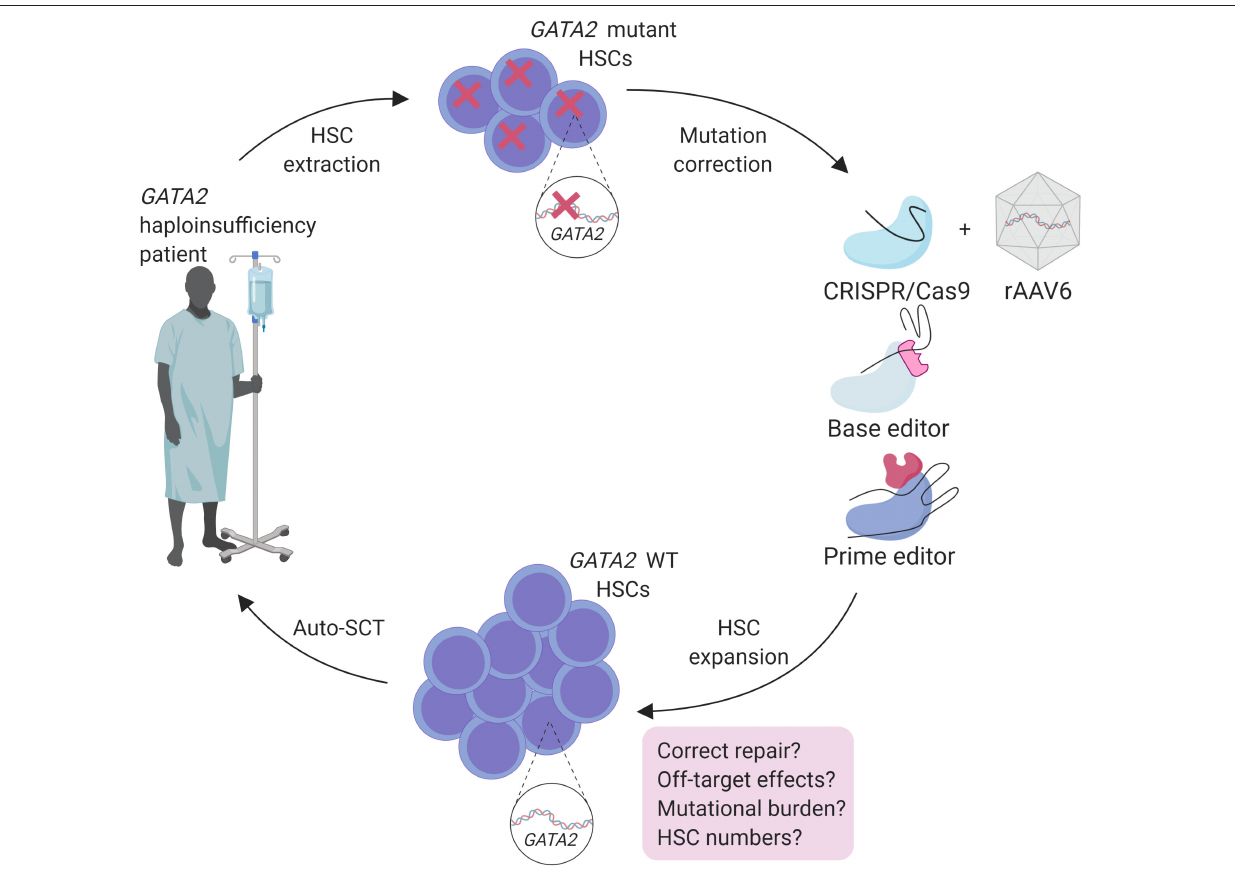
FIGURE 2 | Treatment strategy for genome engineering of autologous HSC of GATA2 haploinsufficiency patients with safety considerations.